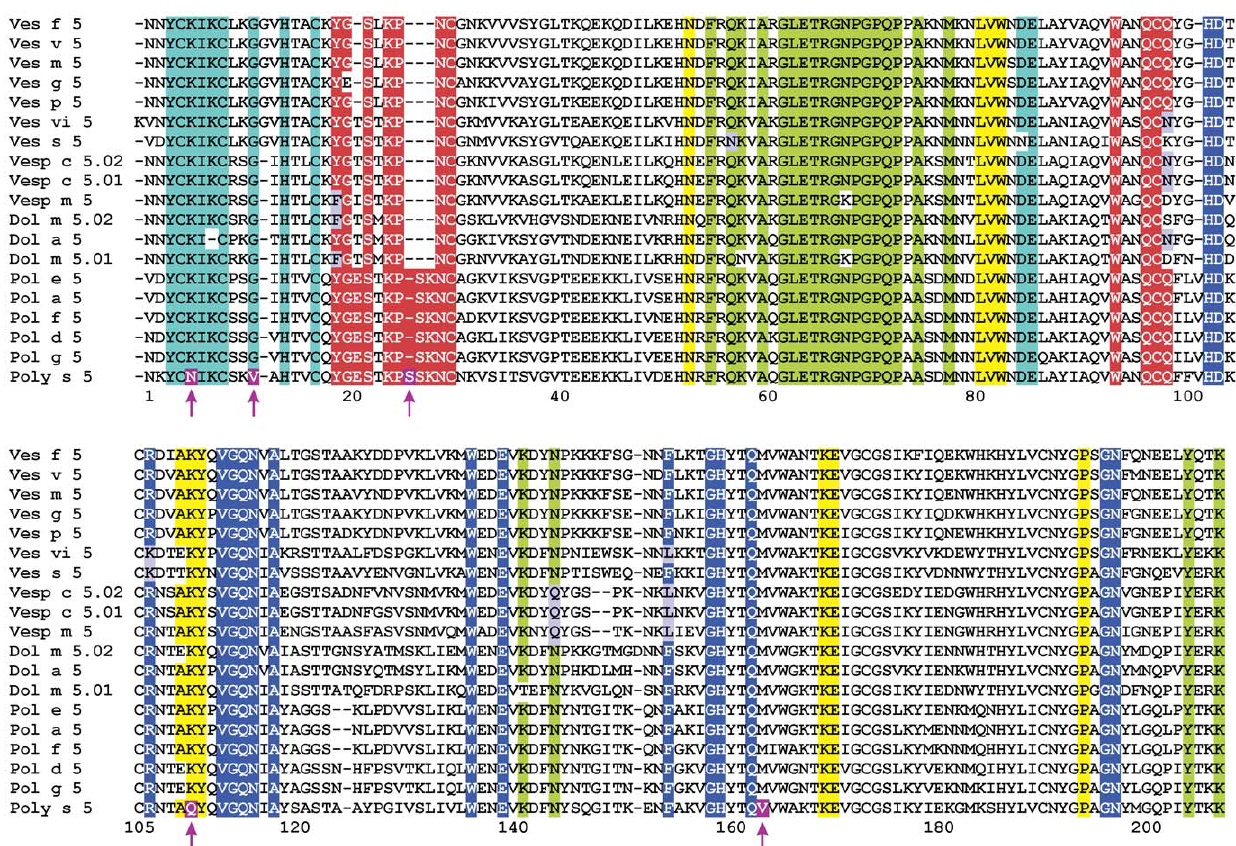
Figure 6. Sequence alignment of vespid Ag 5 s. From top to bottom: Ves f 5, Vespula flavopilosa Ag 5 (P35783); Ves v 5, V. vulgaris Ag 5 (Q05110); Ves m 5, V. maculifrons Ag 5 (P35760); Ves g 5, V. germanica Ag 5 (P35784); Ves p 5, V. pensylvanica Ag 5 (P35785); Ves vi 5, V. vidua Ag 5 (P35787); Ves s 5, V. squamosa Ag 5 (P35786); Vesp c 5.02, Vespa crabro Ag 5 (P35782); Vesp c 5.01, V. crabro Ag 5 (P35781); Vesp m 5, V. mandarinia Ag 5 (P81657); Dol m 5.01, Dolichovespula maculata Ag 5 (P10736); Dol a 5, D. arenaria Ag 5 (Q05108); Dol m 5.02, D. maculata Ag 5 (P10737); Pol e 5, Polistes exclamans Ag 5 (P35759); Pol a 5, P. annularis Ag 5 (Q05109); Pol f 5, P. fuscatus Ag 5 (P35780); Pol d 5, P. dominulus Ag 5 (P81656); Pol g 5, P. gallicus Ag 5 (P83377); Poly s 5, Polybia scutellaris Ag 5 (Q7Z156). Fully conserved residues of the five ( # 1–5) proposed epitopes are on cyan, red, yellow, green and blue background respectively. Residues which are non-conserved or conservatively substituted are on white and gray background respectively. Residues exclusively changed in Poly s 5 are on purple background and marked with arrows. Numbering corresponds to the Poly s 5 sequence.